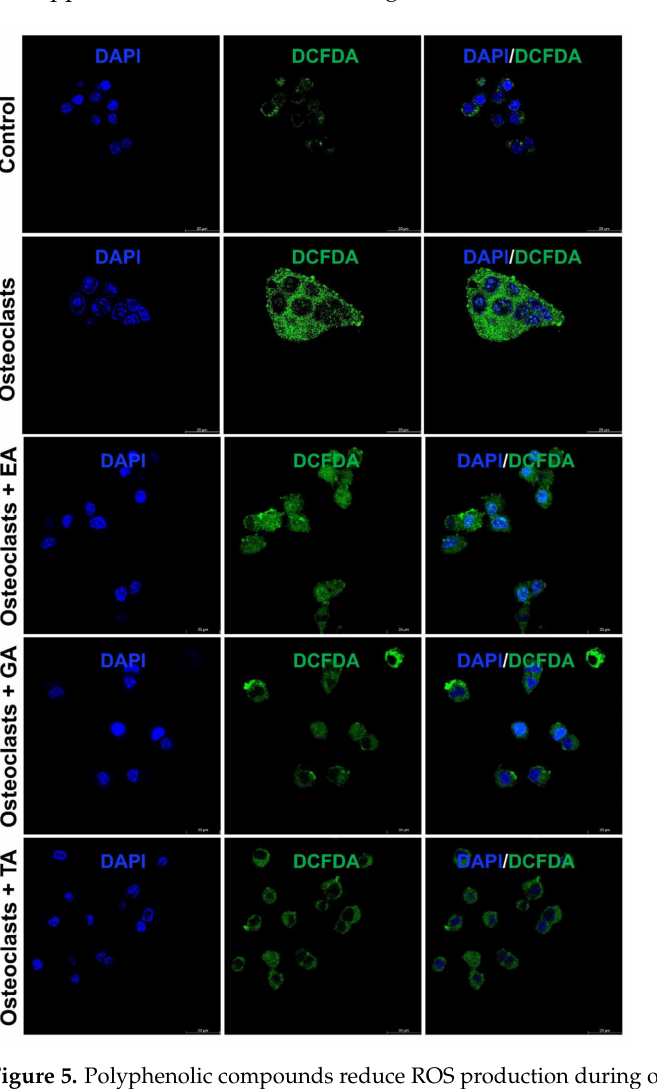
Figure 5. Polyphenolic compounds reduce ROS production during osteoclast differentiation. Evalua- tion of ROS production levels, determined by DCFDA fluorescence staining was shown at day 6 in the absence or presence of ellagic acid (EA), gallic acid (GA), or tannic acid (TA) during osteoclast